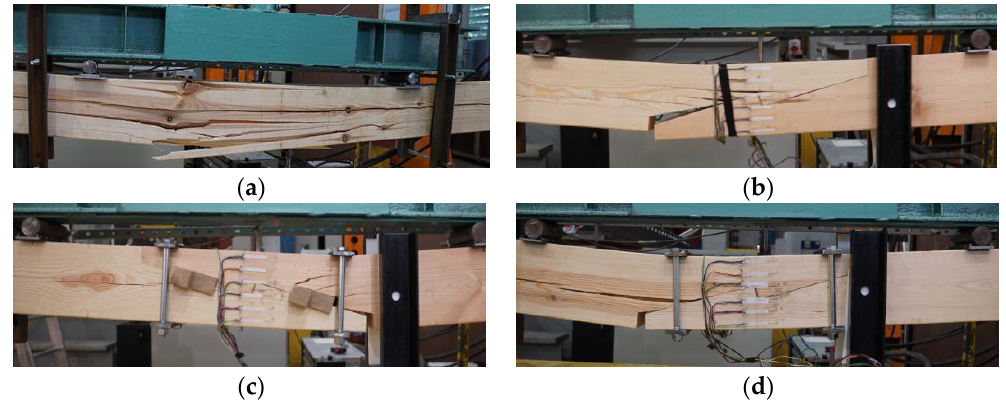
Figure 15. Failure views for selected beams ( a ) A01, ( b ) E03, ( c ) F01, ( d ) G02.